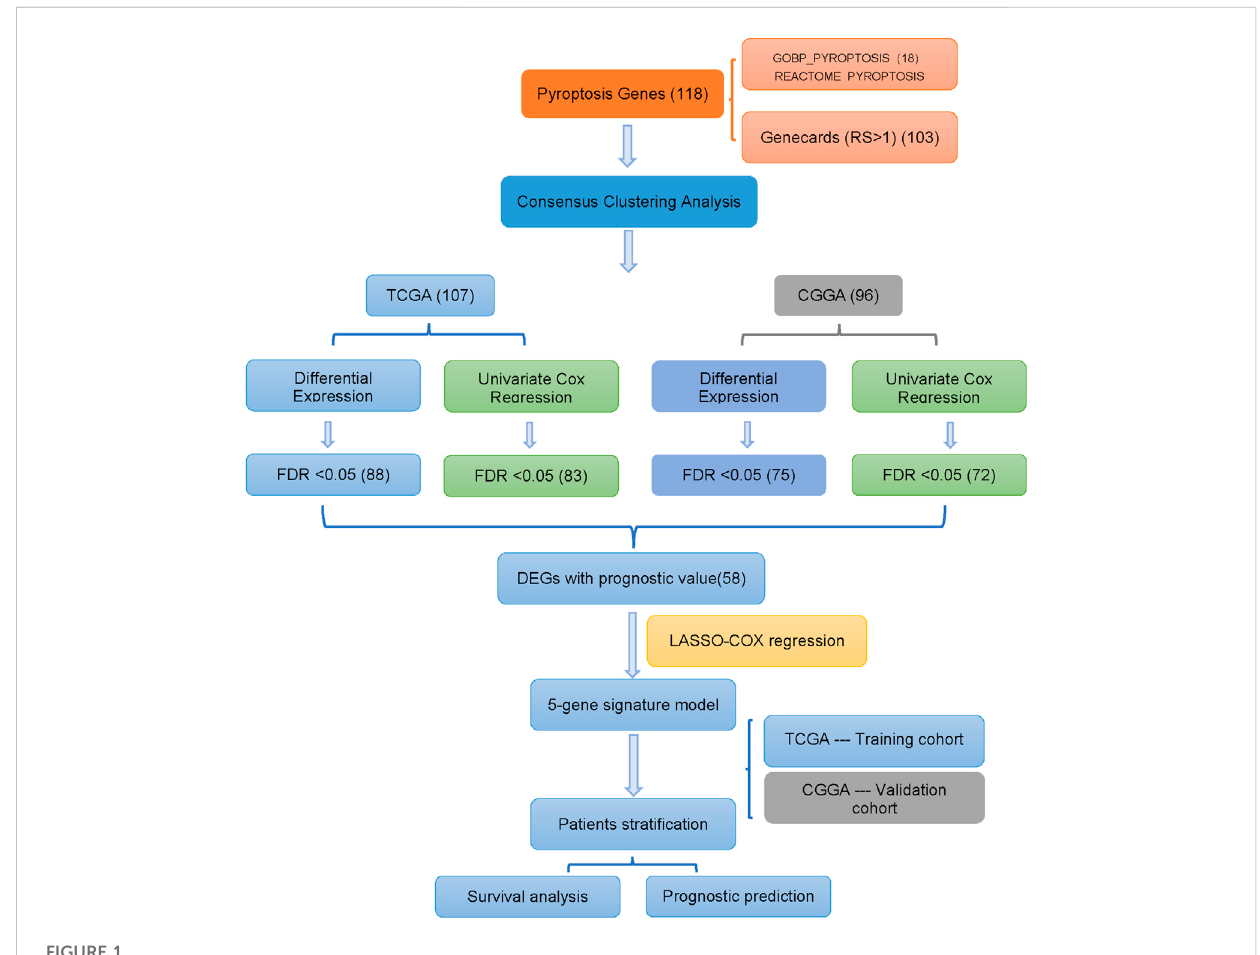
FIGURE 1 Flow chart of data collection and